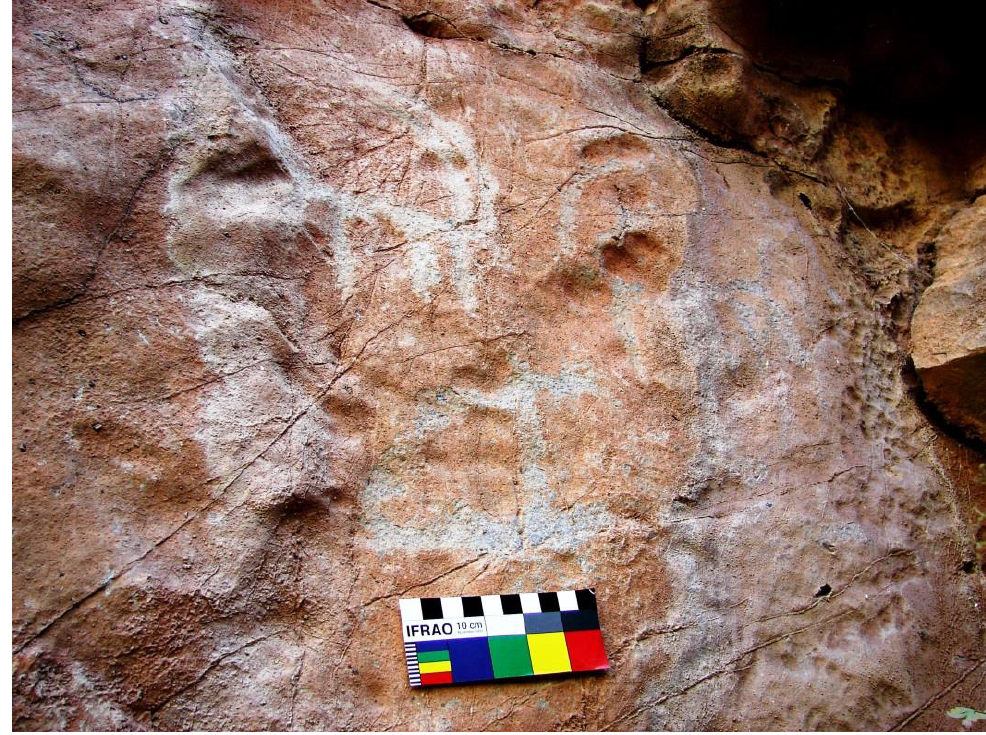
Figure 5. The Images of zoomorphs and an oval-resembling symbol divided into two